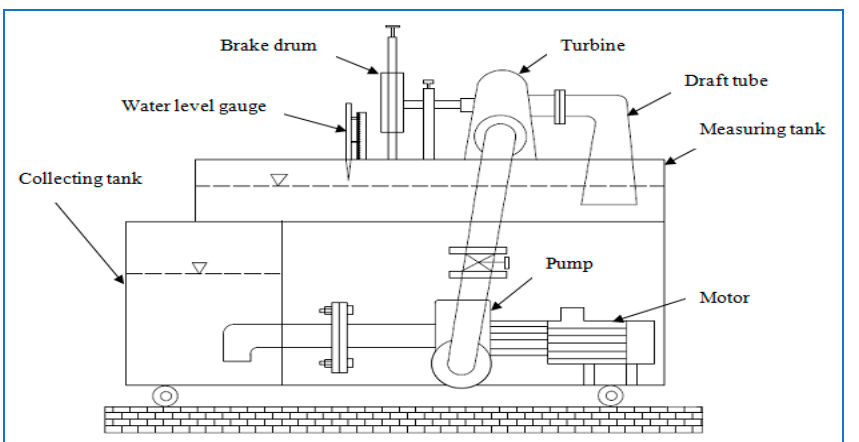
Figure 2. Schematic of Francis turbine test setup.